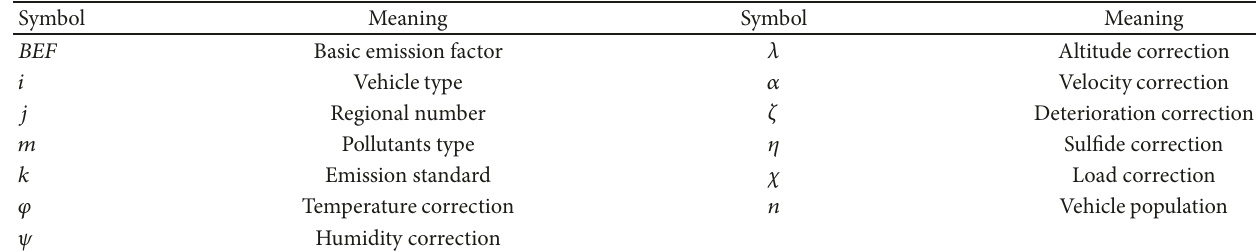
Table 9: The meaning of each symbol in the formula.